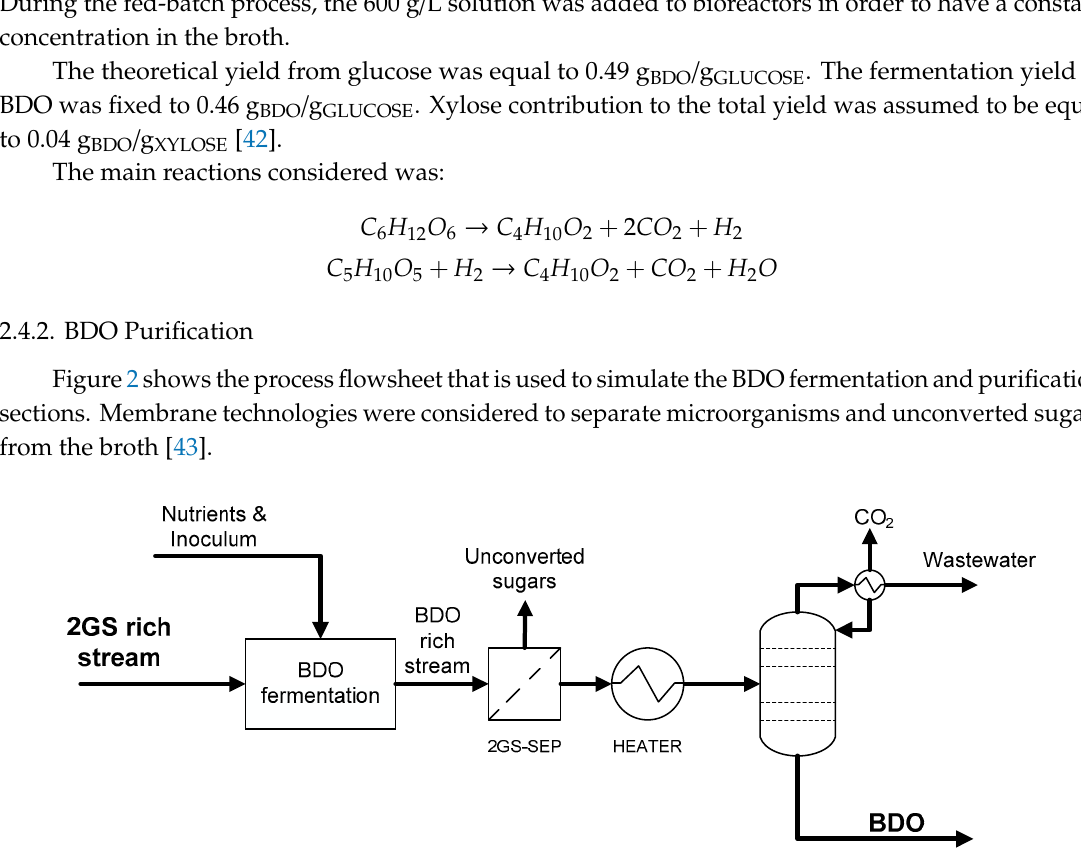
Figure 2. Process simulation flowsheet for the BDO fermentation and purification.